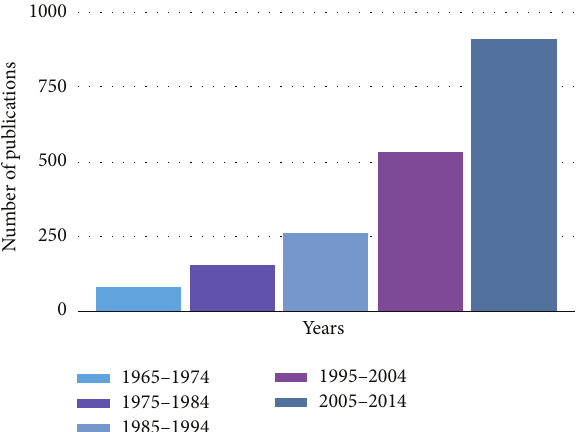
Figure 1: Increasing number of data observing orthodontics with periodontology reflects the increasing interest in multidisciplinary approach with